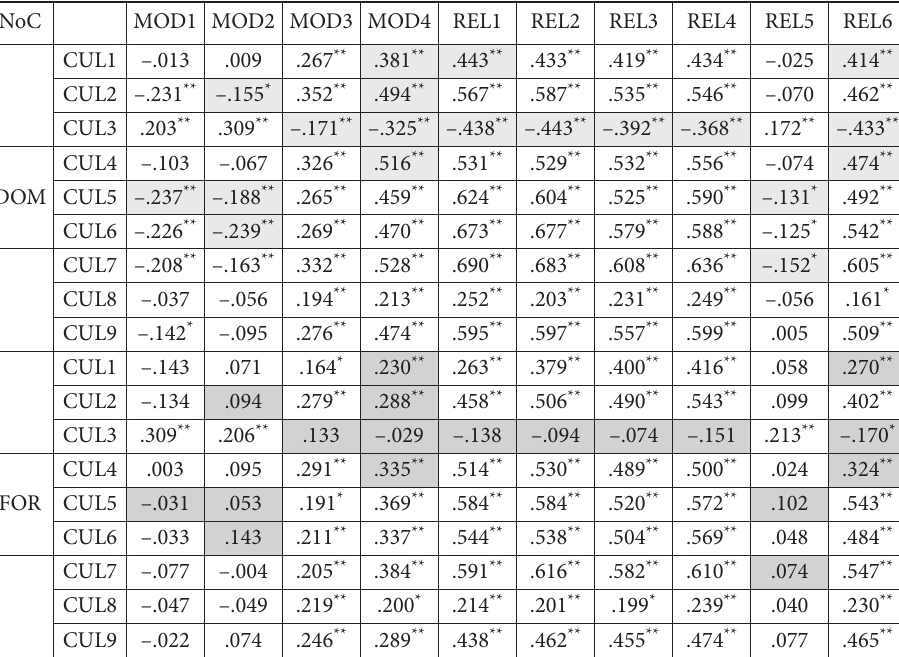
Table 4. Correlation coefficients between the organizational culture dimensions and the CMPR dimen- sions and the OPR dimensions, for domestic companies (DOM) and foreign companies (FOR) NoC MOD1 MOD2 MOD3 MOD4 REL1 REL2 REL3 REL4 REL5 CUL1 –.013 .009